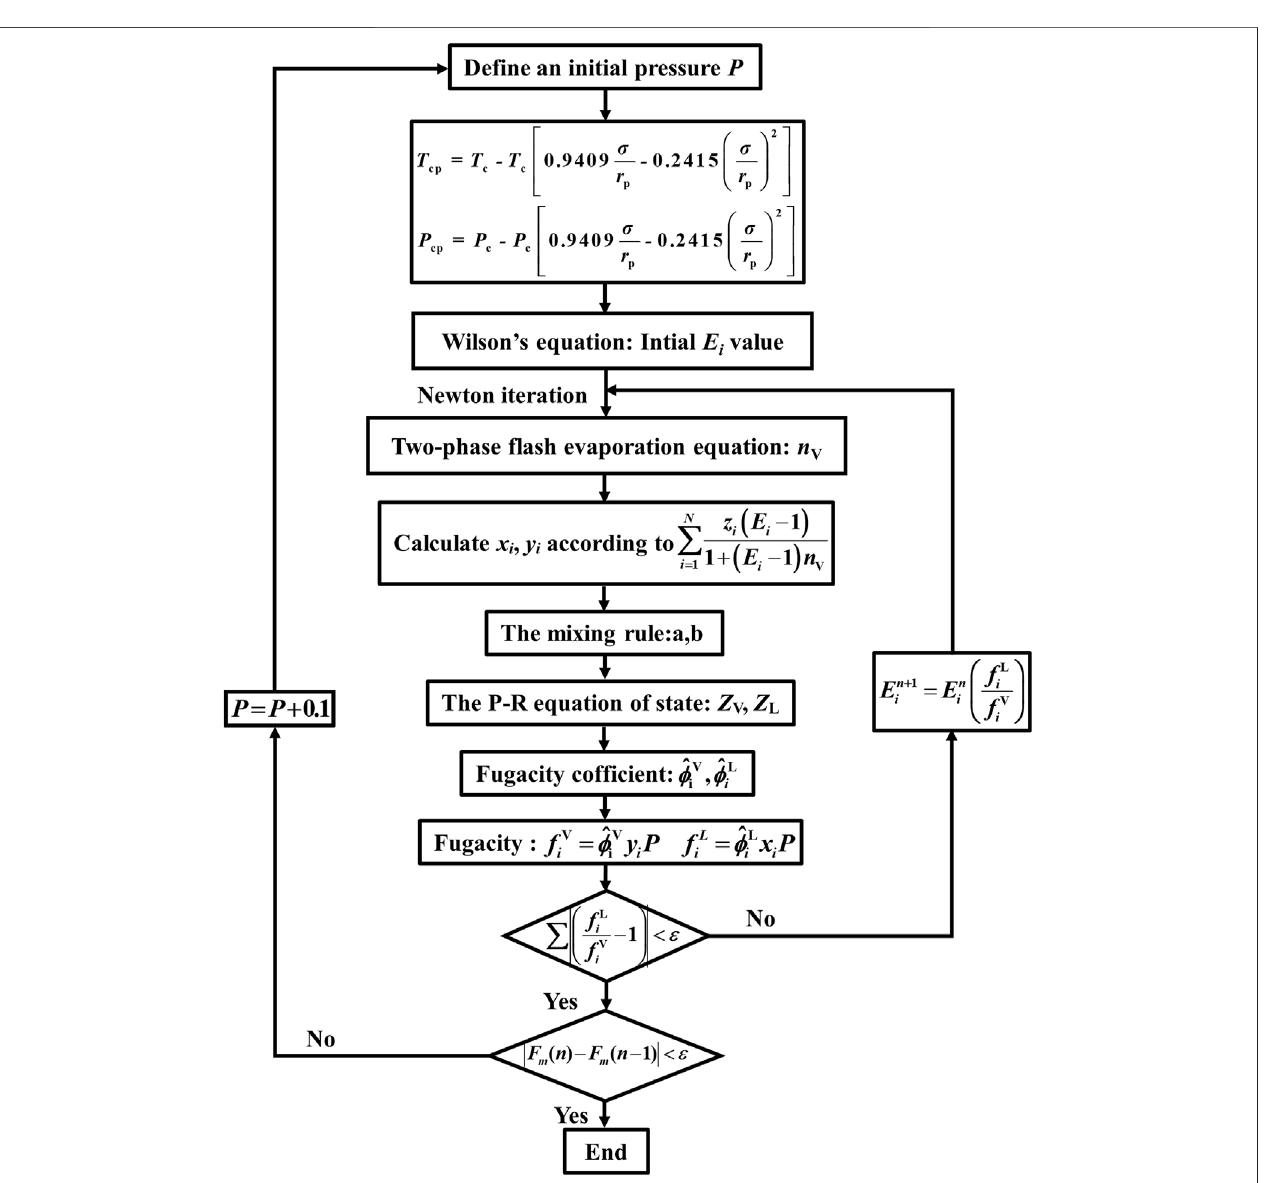
FIGURE 5 | Process chart of the calculation of the MMP prediction model based on microscopic pore-throat structure.